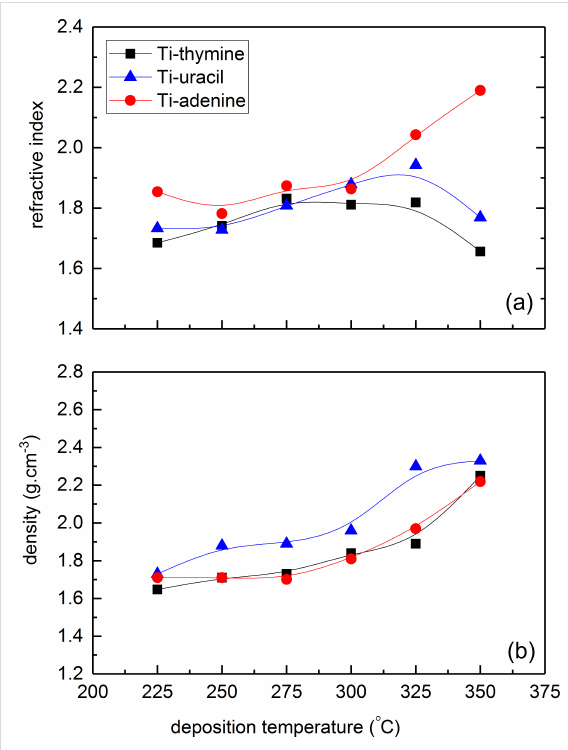
Figure 5: (a) Refractive index at 632.8 nm as measured by spectros- copic ellipsometry and (b) film density as measured by X-ray reflec- tivity (XRR) as a function of substrate temperature for TTIP and adenine (red circles), thymine (black square) and uracil (blue triangle).